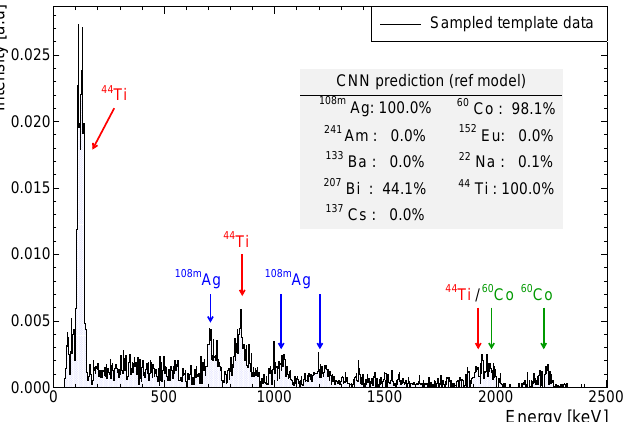
Figure 1. Example 4 × 10 3 count NaI spectrum (7.05(1)% @662 keV) containing natural background, 108 m Ag, 44 Ti and 60 Co. A 31 keV threshold and gain shift of × 1.7 are applied. Note the ambiguity in model predictions (see Section 5.2) for 207 Bi, which is extremely similar in profile to 44